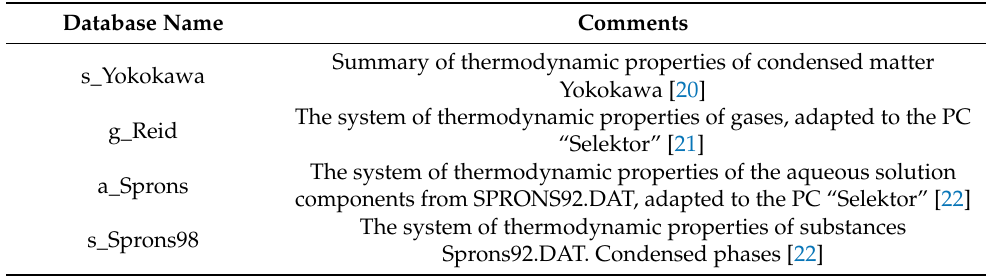
Table 1. A quick reference to the thermodynamic databases included in the model.